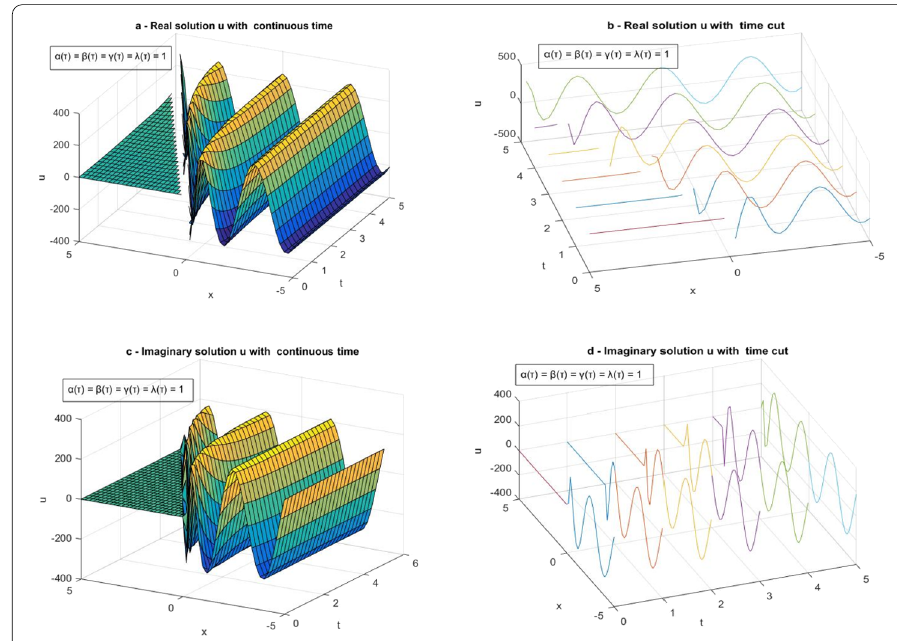
Figure 4 The graphs of the classic case of Example 2 where α ( τ ) = β ( τ ) = γ ( τ ) = λ ( τ ) =